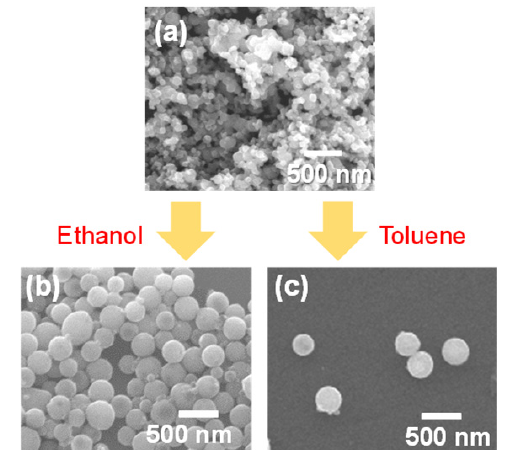
Figure 1. TiC SMP fabrication from TiC NPs via PLML. ( a ) SEM image of raw TiC NPs (<200 nm). SMPs obtained by 532 nm Nd:YAG laser irradiation at 150 mJ pulse − 1 cm − 2 ( b ) in ethanol for 10 min and ( c ) in toluene for 120 min.